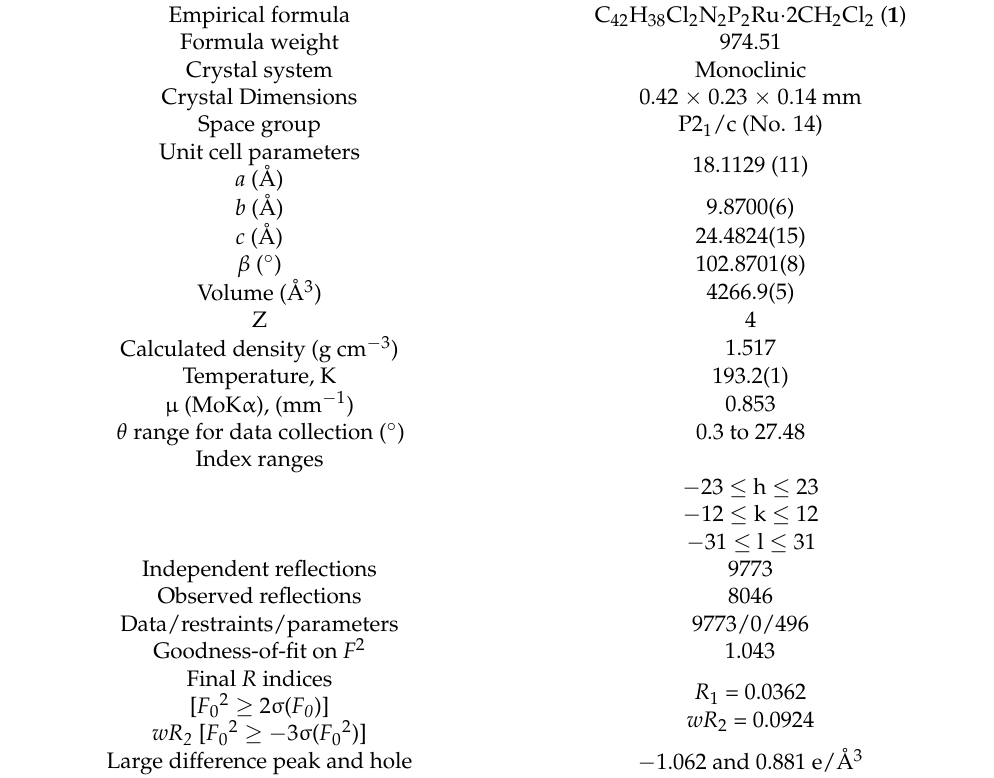
Table 2. Crystal data and structure refinement details for complex 1